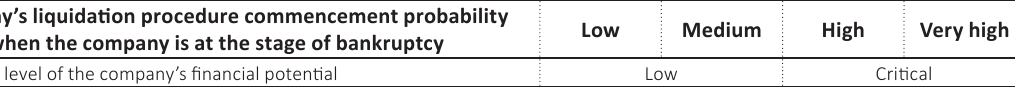
Source: Developed by the